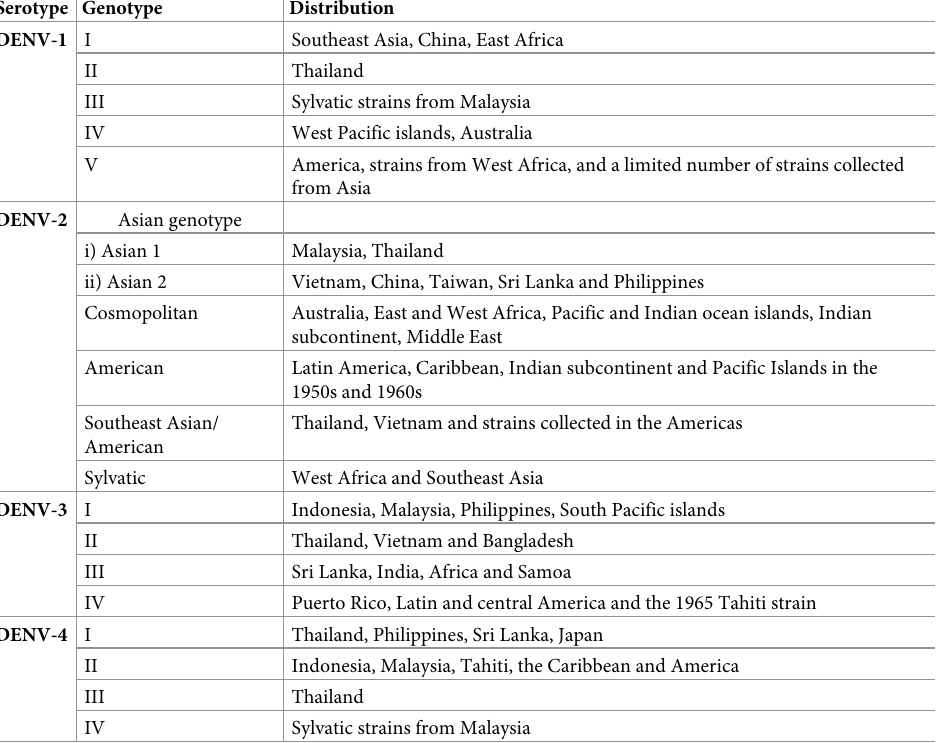
Table 1. DENV serotypes and genotypes